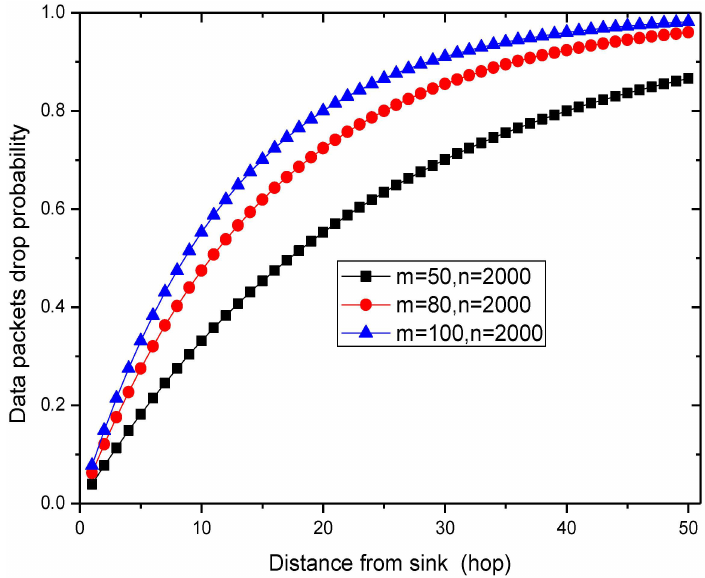
Figure 7. The data drop